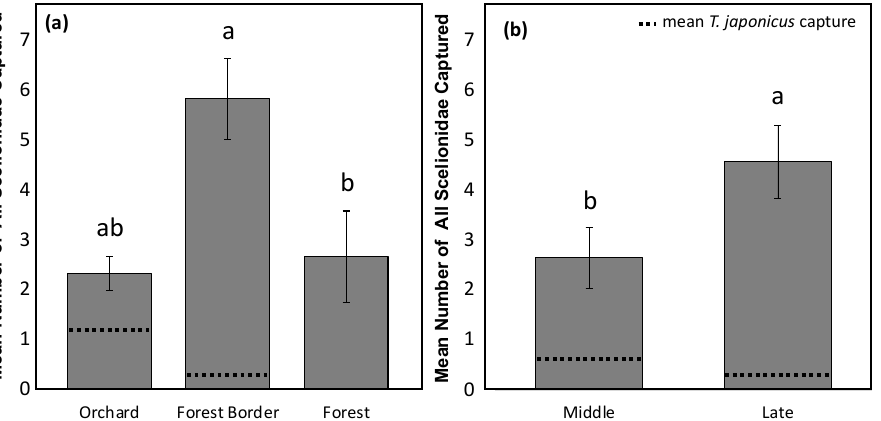
Figure 2. Mean number of all Scelionidae parasitoids captured in 2018 on YSC in ( a ) three habitats